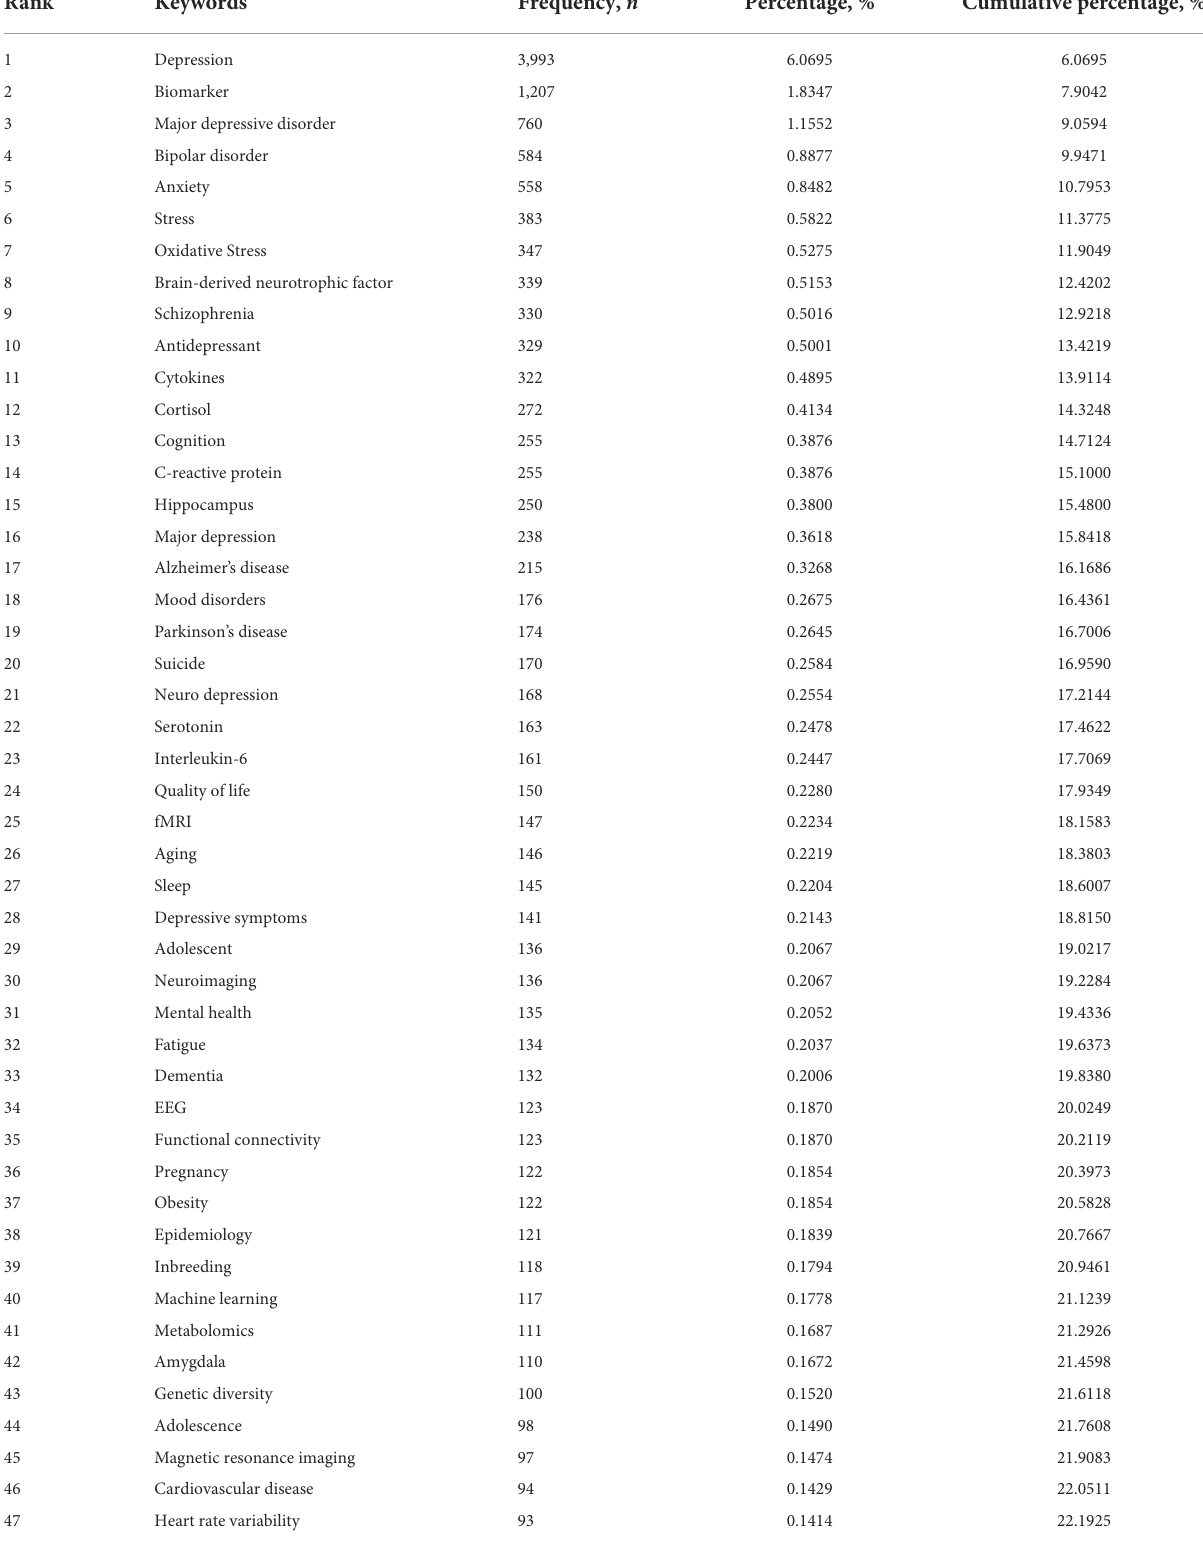
TABLE 3 Top 70 high-frequency keywords in depression biomarker